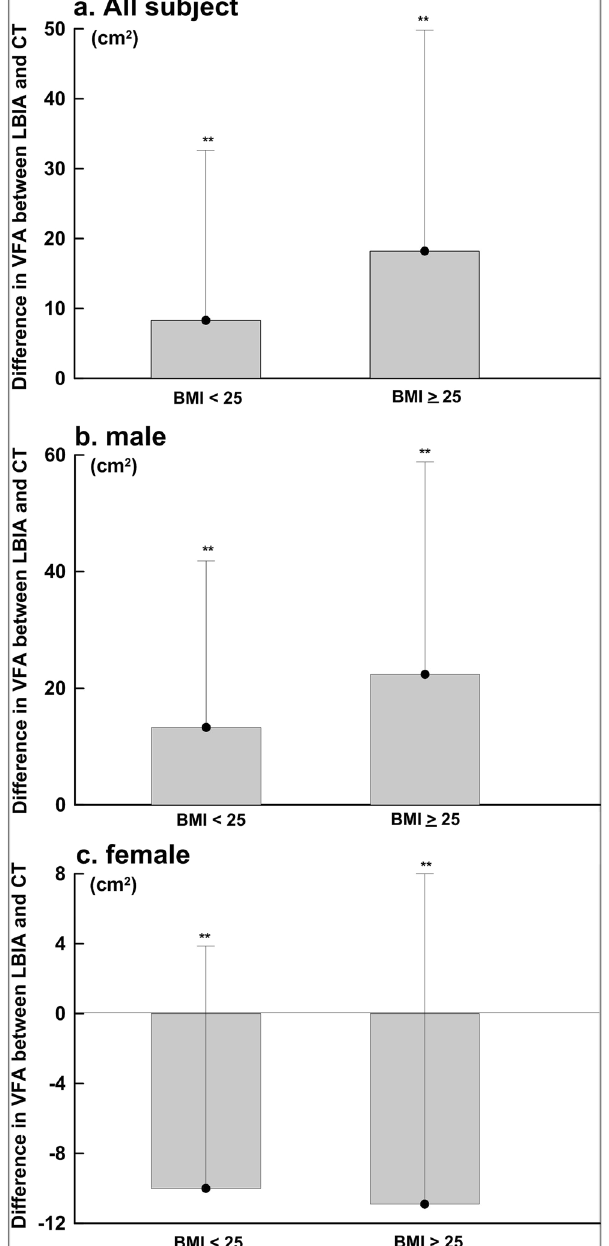
Figure 3. Visceral fat area (VFA) dependent bias of bioelectrical impedance analysis (VFALBIA) compared with computed tomography (VFACT) in ( a ) males and females combined (total, n = 381; BMI < 25 kg/m 2 , n = 235; BMI ≧ 25 kg/m 2 , n = 146), ( b ) male (total, n = 240; BMI < 25 kg/m 2 , n = 148; BMI ≧ 25 kg/m 2 , n = 92), and ( c ) female (total, n = 141; BMI < 25 kg/m 2 , n = 87; BMI ≧ 25 kg/m 2 , n = 54). Data are presented as the mean difference ± SD. Means with difference symbols are significantly different, ** p < 0.001 (one-factor